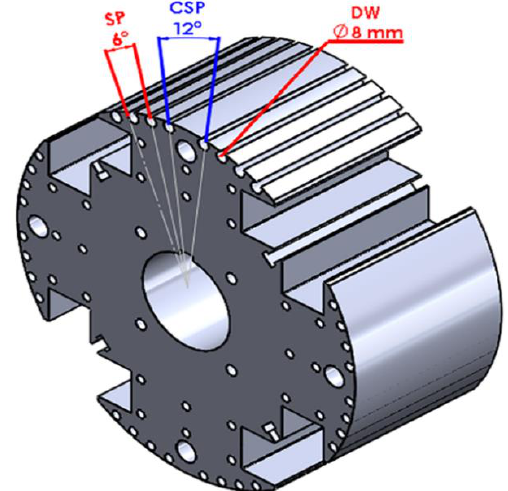
Figure 4. Structure of the optimized